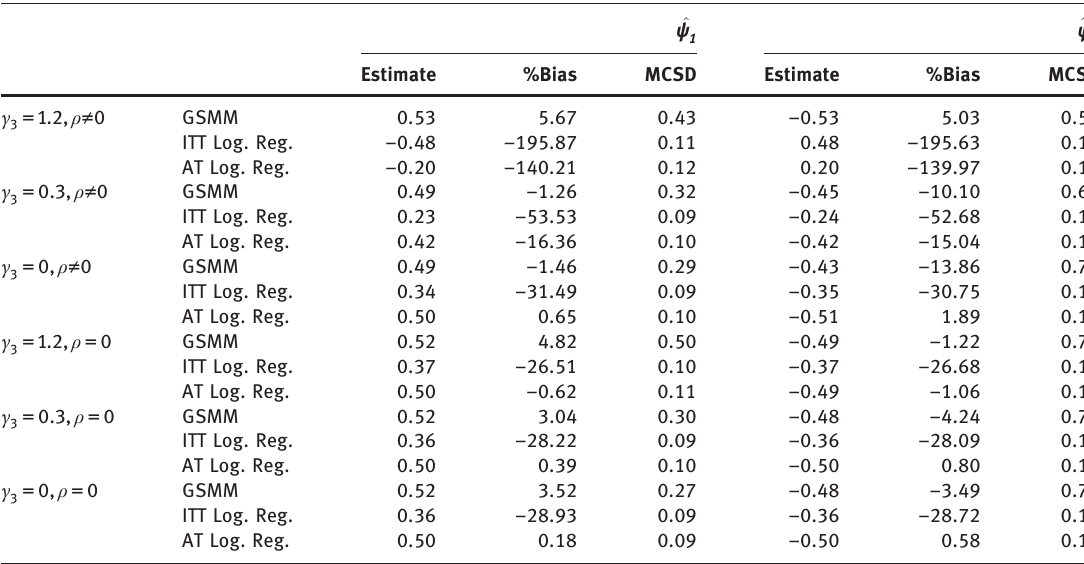
Table 1: Simulation study results. Mean estimates, percent bias, and Monte Carlo standard deviations of the modified G-estimation and standard logistic regression when ignorable noncompliance is present. ρ X = (characterizes the association , γ characterize the association of X and S . γ is the coefficient of A in the data- between baseline covariates X , and ð γ 1 2 Þ 3 generating model for S . ρ =0 indicates that S does not predict Y 0 . The first row in each parameter configuration corresponds to the G-estimation; the second row reports estimates from the intent-to-treat logistic regression; the third row is the as- treated logistic regression.